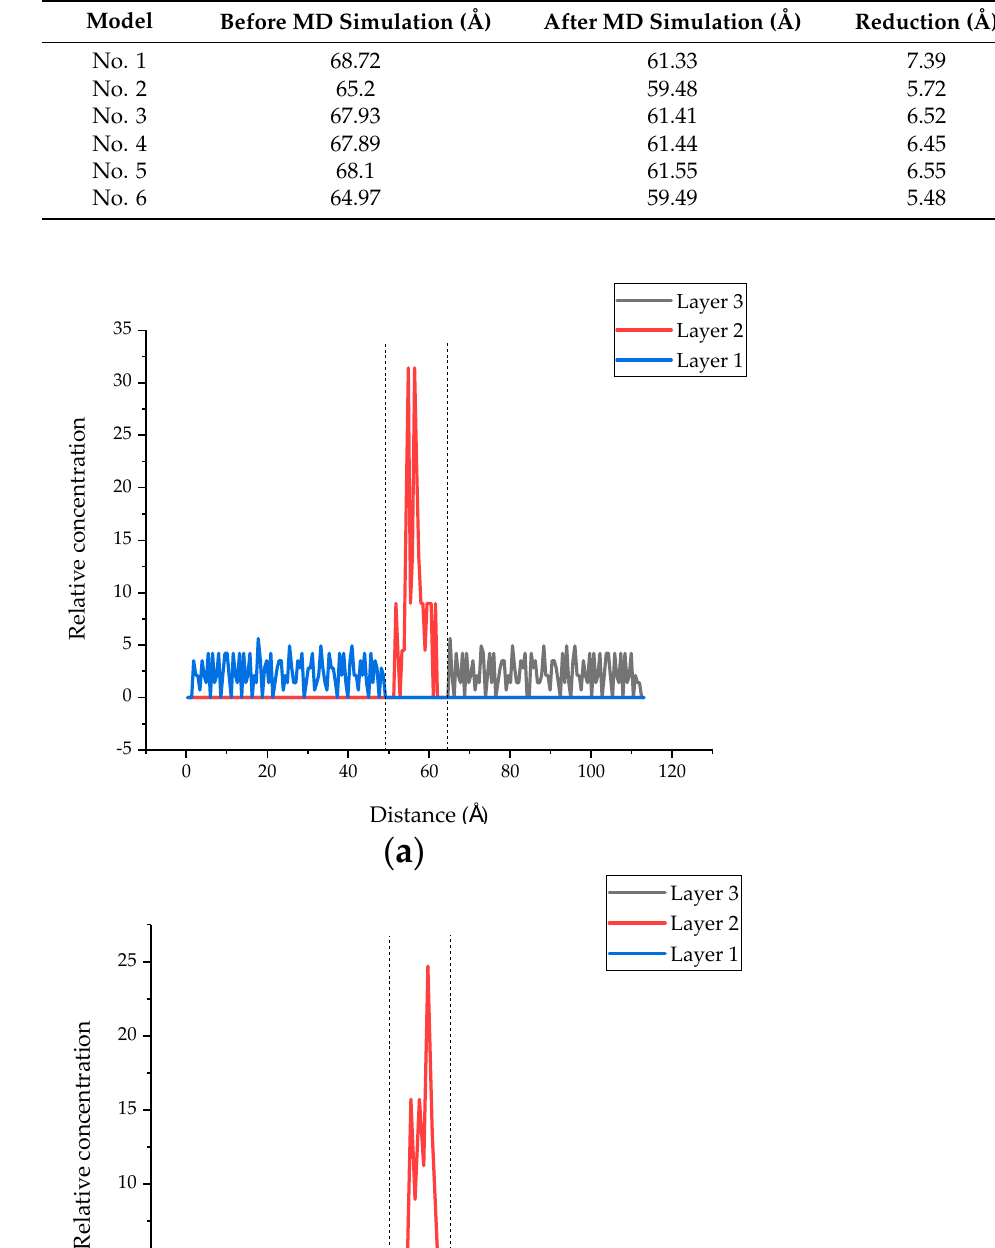
Table 2. Cell lengths in the Z direction.